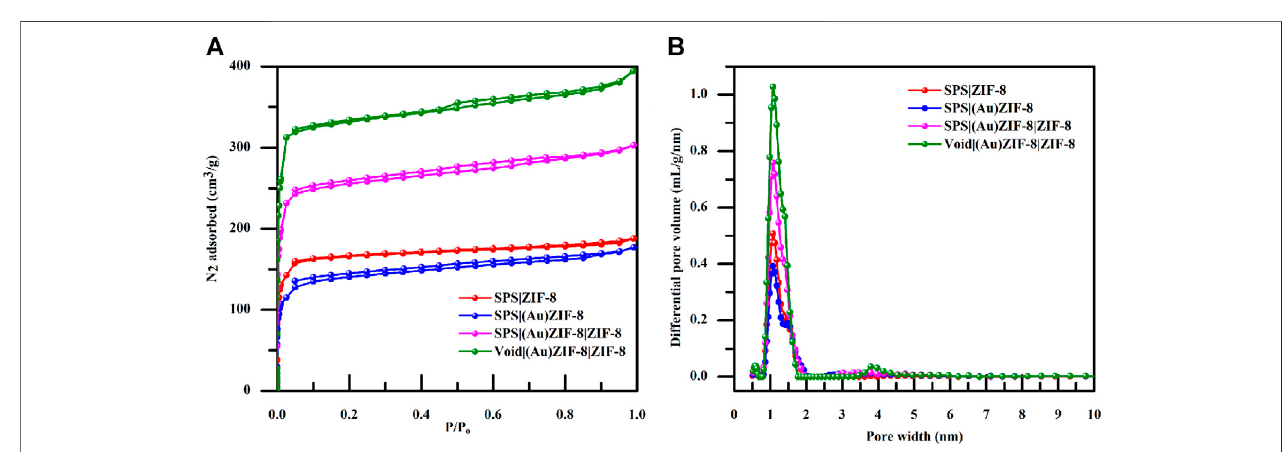
FIGURE 6 | (A) Dinitrogen isotherms of SPS|ZIF-8 (red); SPS|(Au)ZIF-8 (blue); SPS|(Au)ZIF-8|ZIF-8 (magenta) and Void|(Au)ZIF-8|ZIF-8 (olive). (B) Pore size distribution image information of SPS|ZIF-8 (red); SPS|(Au)ZIF-8 (blue); SPS|(Au)ZIF-8|ZIF-8 (magenta) and Void|(Au)ZIF-8|ZIF-8 (olive).